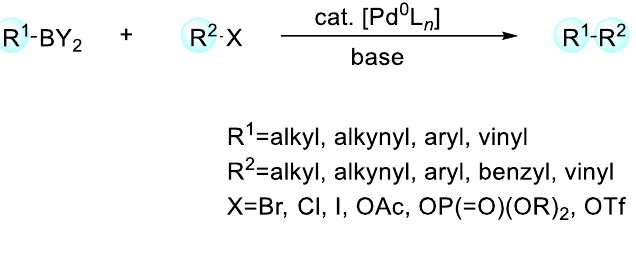
Scheme 1. Traditional Suzuki coupling reaction.